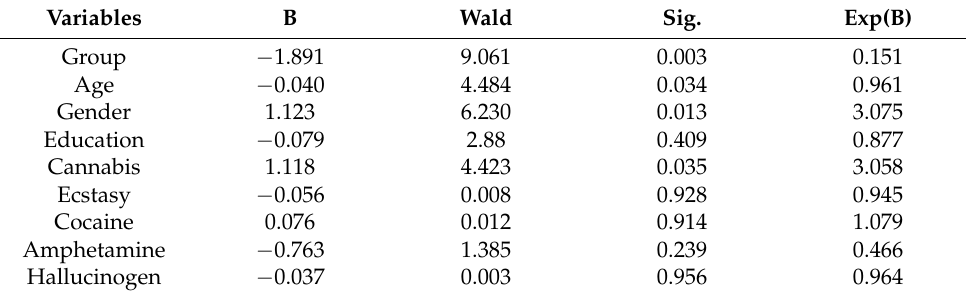
Table 5. Results of the hierarchical binary logistic regression